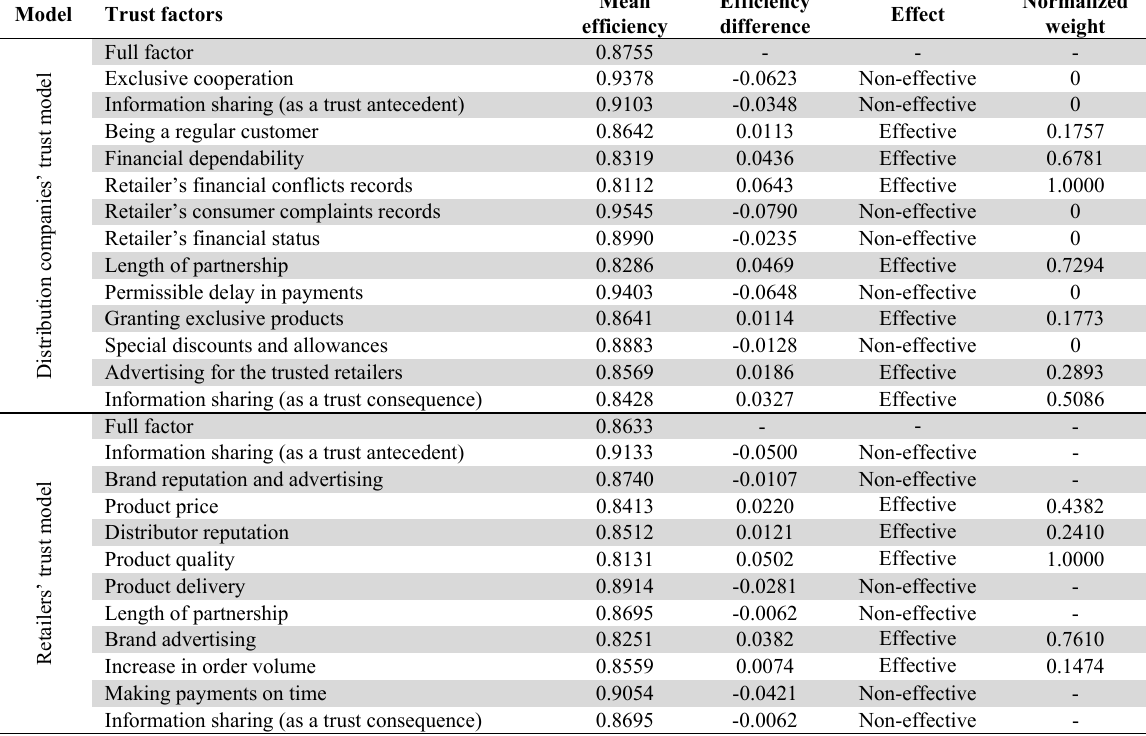
The estimated performance weight of each trust factor